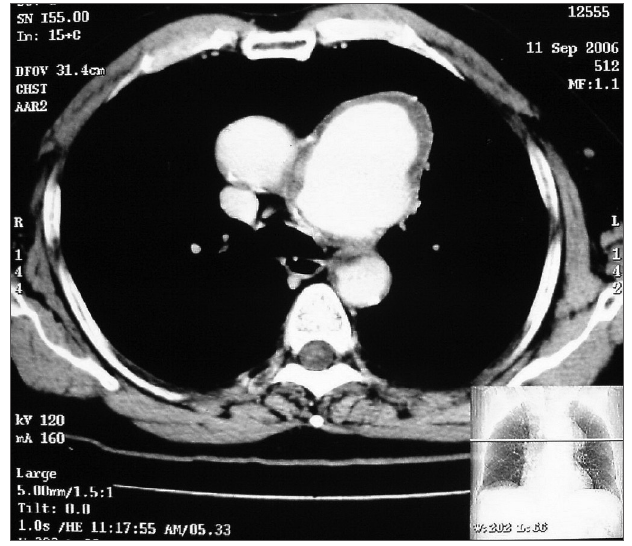
Figure 3. Contrast enhanced CT scan chest, axial view showing large, lobulated, enhancing saccular aneurysm arising from the arch of aorta with peripheral